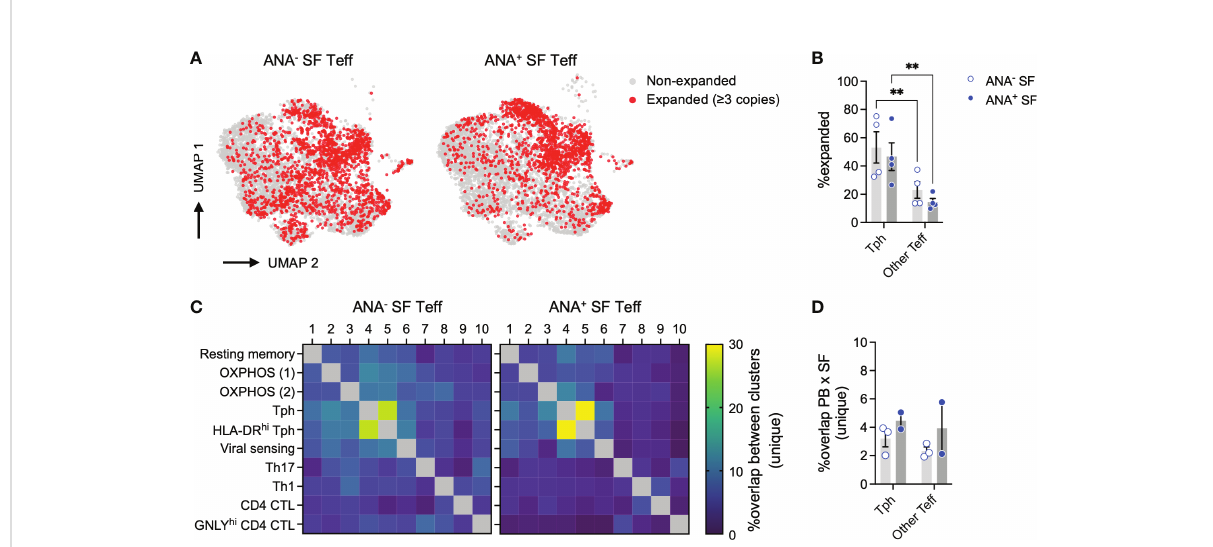
FIGURE 7 T peripheral helper cells in oligo JIA SF are clonally expanded. (A) UMAP of SF Teffs with known TCR alpha and beta chains from 8 oligo JIA patients, highlighting expanded clonotypes. (B) Percent of expanded clonotypes among total SF Tph (Clusters 4 and 5) or other SF Teff (Clusters 1-3 and 6-10) cells. (C) Heatmap showing the percent of overlap in unique clonotypes between each pair of clusters identi fi ed in SF Teffs, split by ANA status. (D) Percent of overlap in unique clonotypes between total PB Teff and SF Tph (Clusters 4 and 5) or other SF Teff (Clusters 1-3 and 6-10) cells. Oligo JIA; oligoarticular juvenile idiopathic arthritis; SF, synovial fl uid; PB, peripheral blood; Teff, effector T cell; Tph, T peripheral helper cell; ANA, antinuclear antibody; UMAP, uniform manifold approximation and projection; OXPHOS, oxidative phosphorylation; CTL,